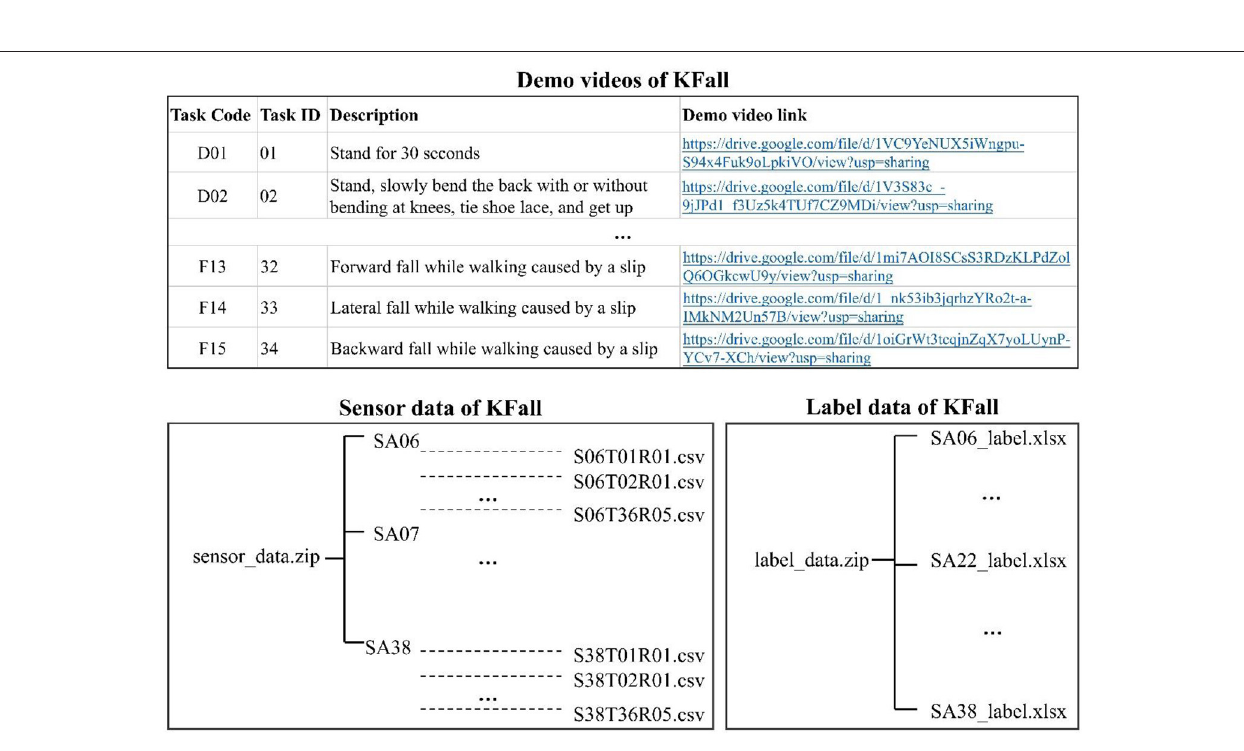
FIGURE 5 | Organization of the KFall dataset provided in the